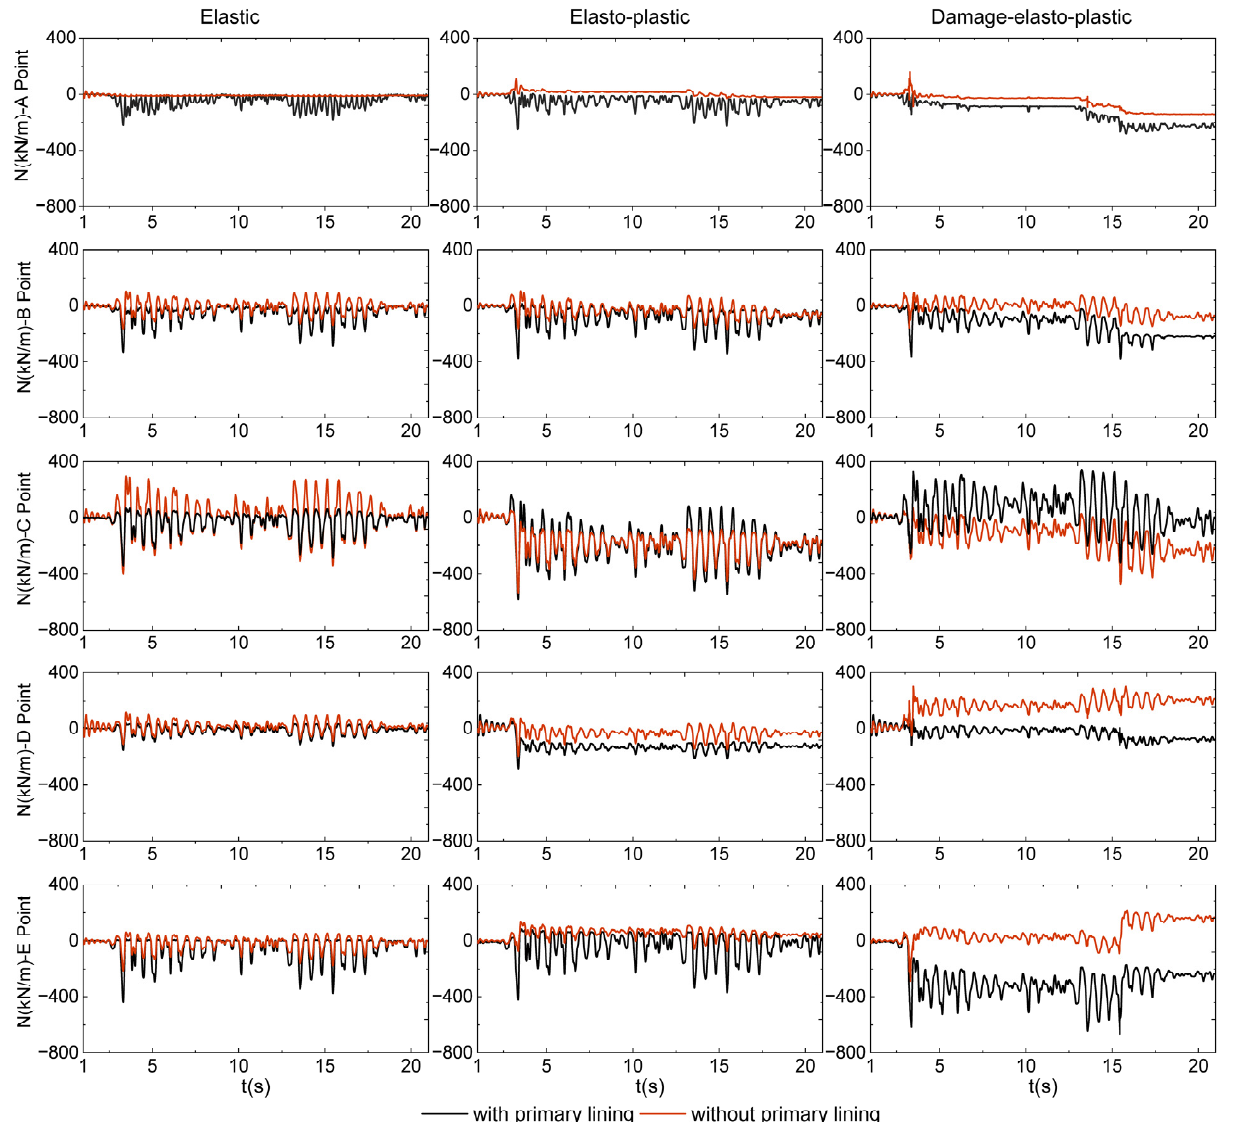
Figure 19. Dynamic axial force time histories at crucial sections of tunnel (A/B/C/D/E) computed for EQ1. First column: elastic analysis result. Second column: elasto-plastic analysis result. Third column: damage plastic analysis result.